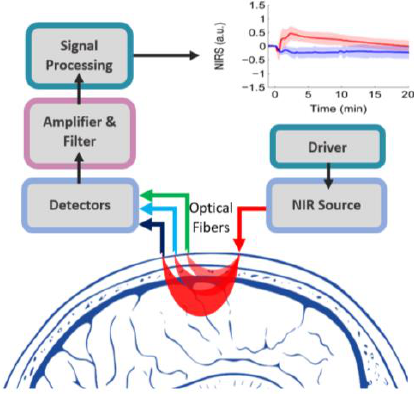
Figure 1. The basic principle of the functional near-infrared spectroscopy (fNIRS) technique. Penetrations depth is dependent on the distance between source and detector [9].